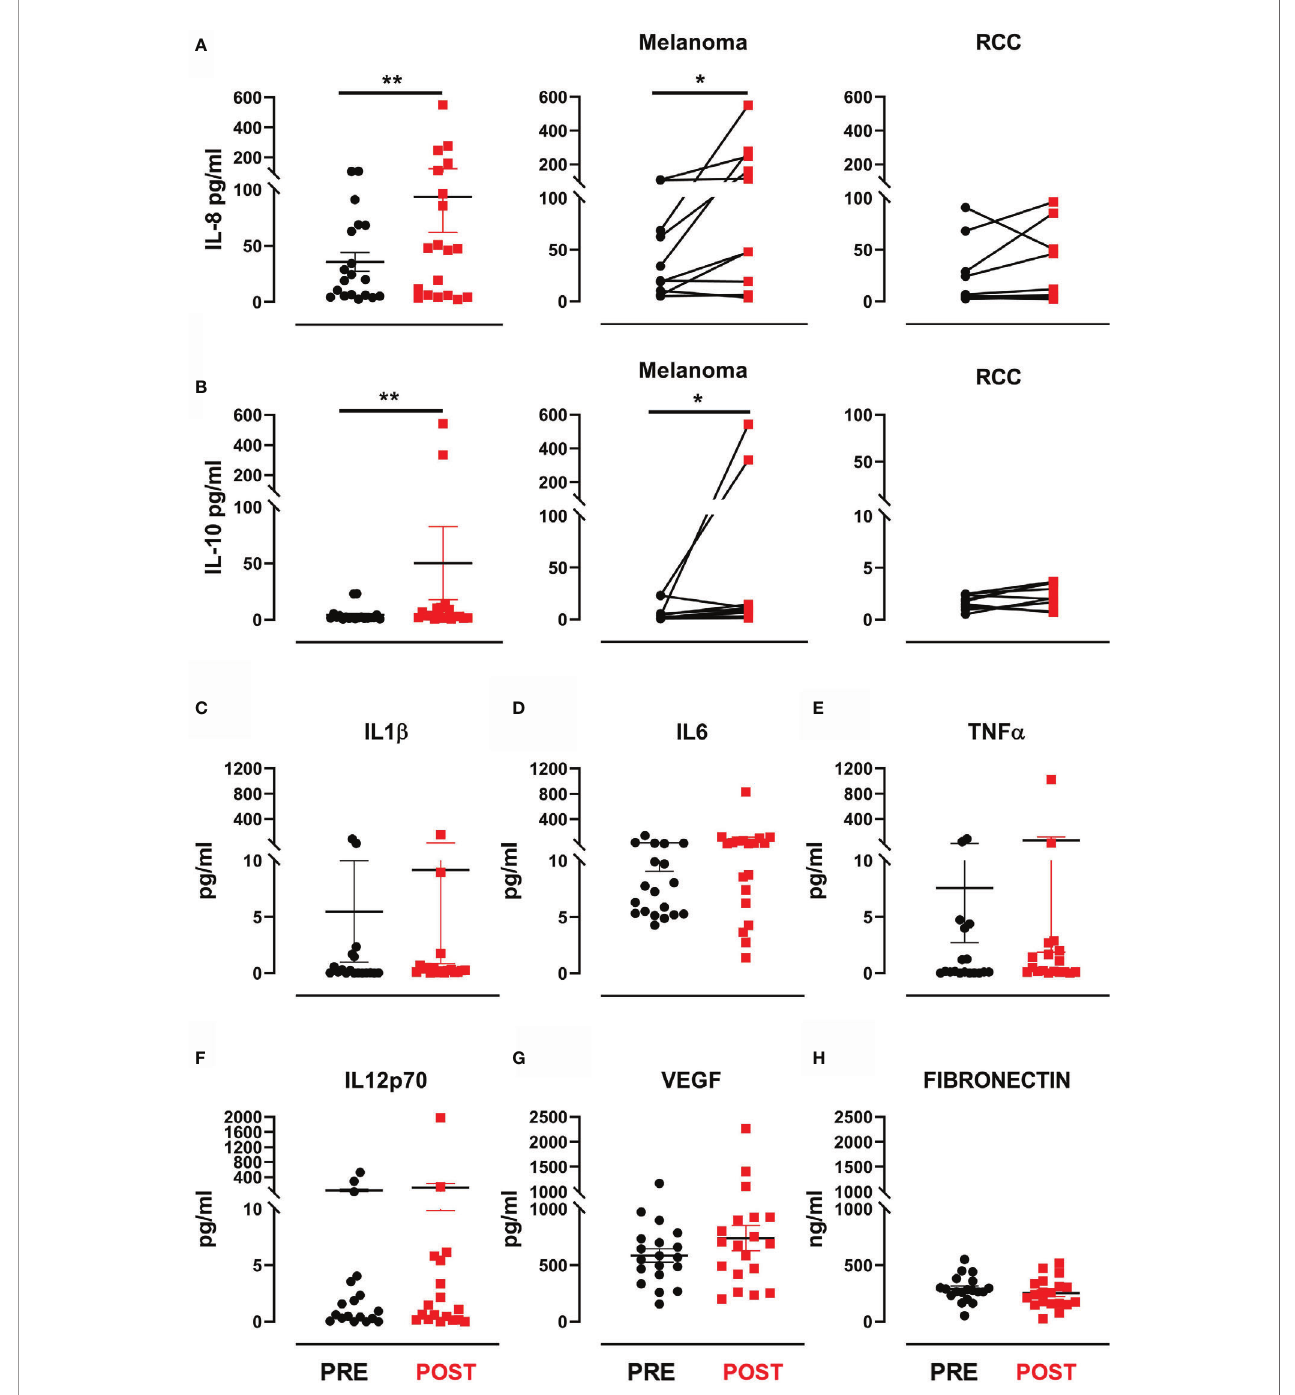
FIGURE 3 | Cytokines and proangiogenic factor modulation after treatment. (A) Dot plot with bar represents IL-8 concentration (pg/mL) in the entire patient cohort (left panel), in MM patients (middle panel) and in RCC patients (right panel). (B) Dot plot with bar represents IL-10 concentration (pg/mL) in the entire patient cohort (leftpanel), in MMpatients (middle panel) andin RCC patients (right panel). Dot plots with bar represent pre- andpost-therapyconcentration levels(pg/mL) of (C) IL-1 b , (D) IL-6, (E) TNF- a , (F) IL-12 p70, (G) VEGF and (H) fi bronectin inng/mL. Data represent individual values, mean (central bar)± SEM (upper and lower bar). The black circular dots represent pre- therapy samples, while the redsquares represent post-therapysamples. Statistical analysis was performed with the nonparametric Wilcoxon signedrank test; * p value < 0.05, ** p value <